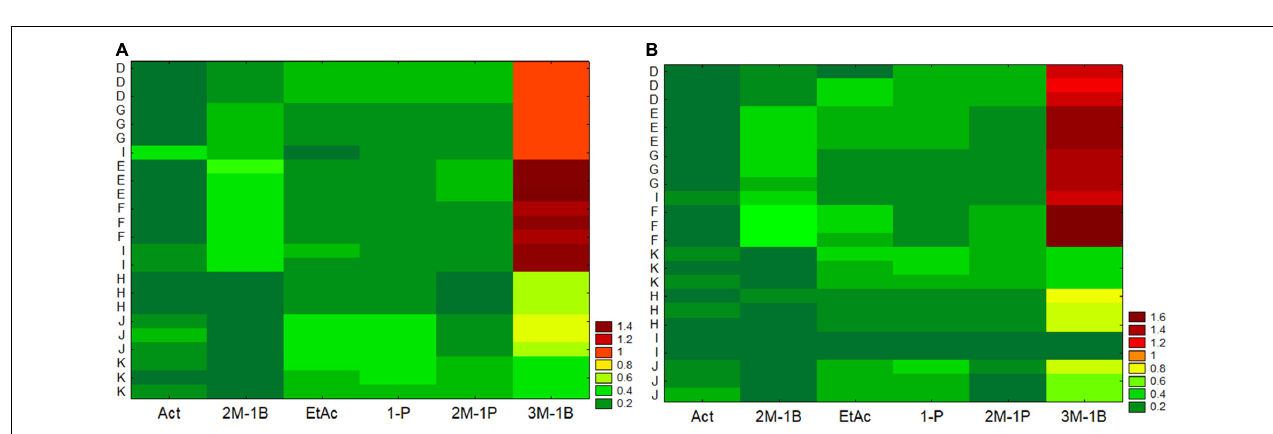
FIGURE 3 | Ethanol (% v/v per unit of consumed sugar) (A) and glycerol yields (g/L per unit of consumed sugar) (B) , and volatile acidity (g/L per unit of consumed sugar) (C) produced by the two strains (EC, AW) in the different grape musts by eight RUs (D, E, F, G, H, I, J, and K). Decomposition of the statistical hypothesis for the interaction strain × RU; the bars indicate 95% confidence intervals.